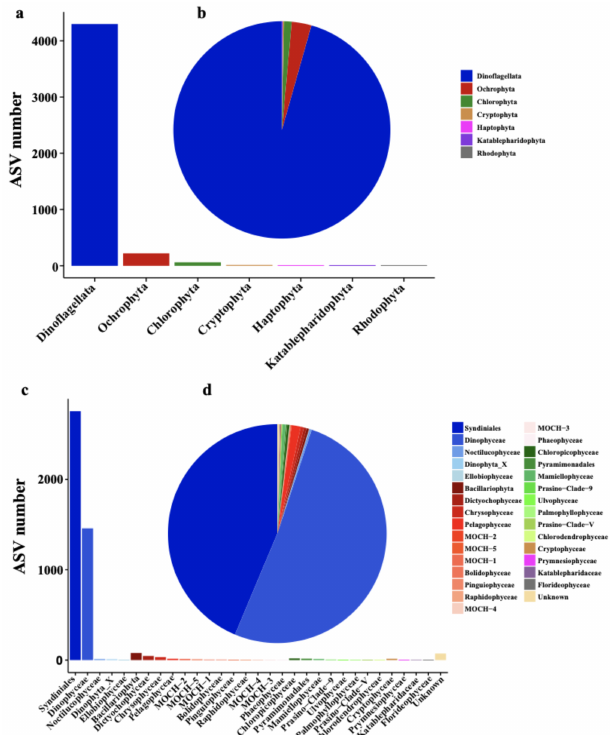
Figure 3. Phytoplankton richness and relative abundance at division/class level in the Western Pacific seamount regions. ( a ) Richness of phytoplankton at division level; ( b ) relative abundance of phytoplankton at division level; ( c ) richness of phytoplankton at class level; ( d ) relative abundance of phytoplankton at class